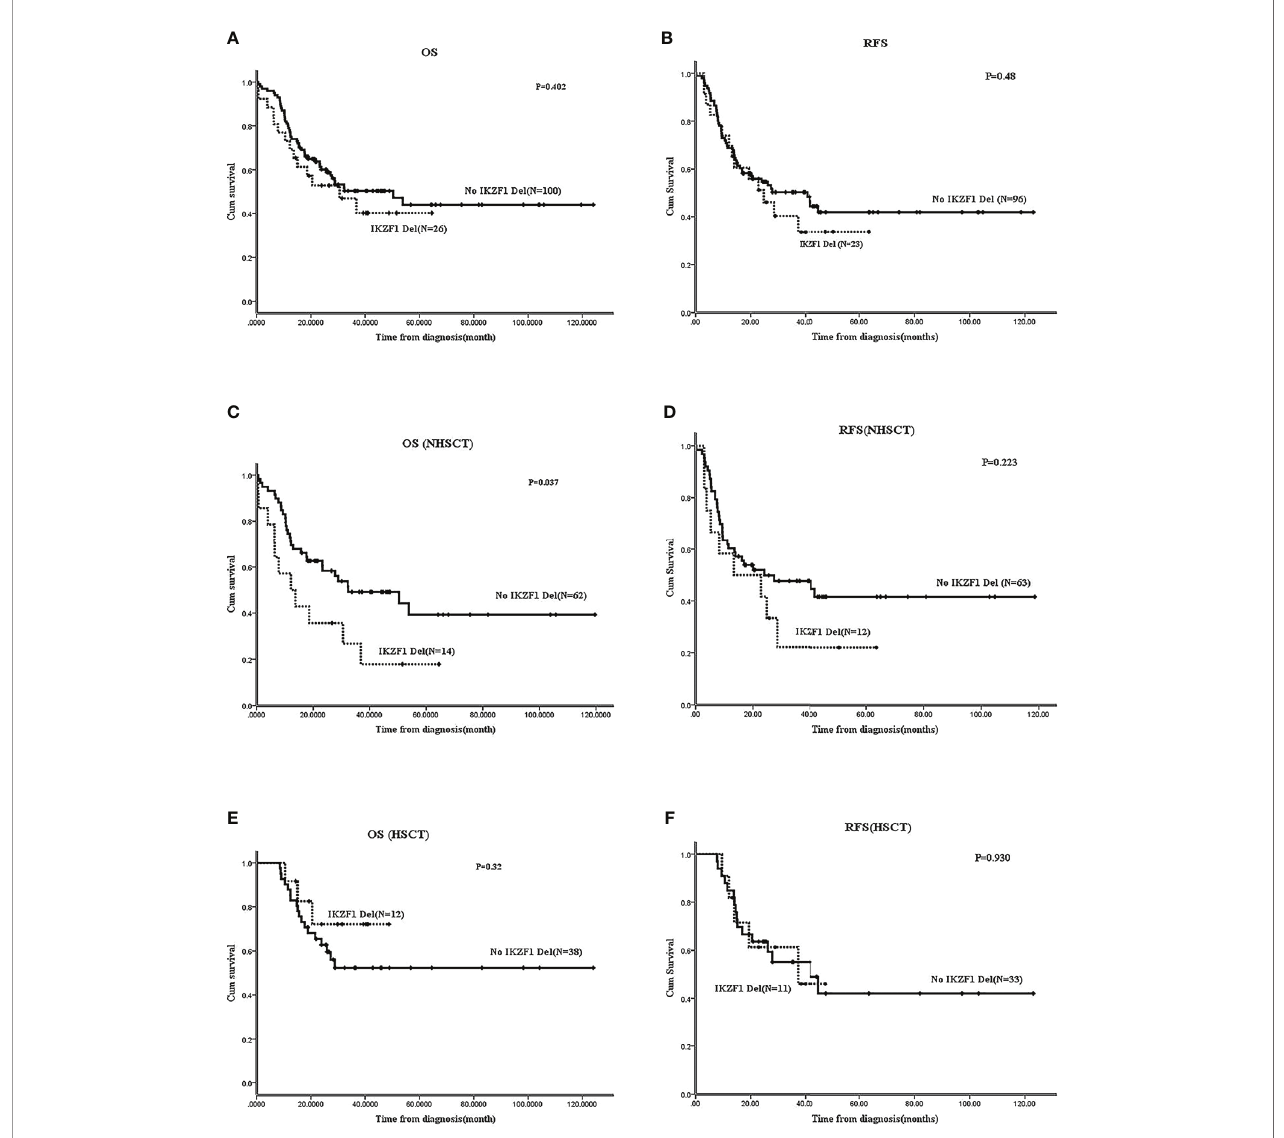
FIGURE 3 | Effect of IKZF1 deletion on survivals of Ph-B-ALL patients by Kaplan-Meier plots. (A, B) The 2-year OS and RFS of Ph - B-ALL patients who carried IKZF1 deletion vs. no IKZF1 deletion. (C, D) The 2-year OS and RFS of Ph - B-ALL patients who carried IKZF1 deletion vs. no IKZF1 deletion in no HSCT group. (E, F) The 2-year OS and RFS of Ph - B-ALL patients who carried IKZF1 deletion vs. no IKZF1 deletion in HSCT